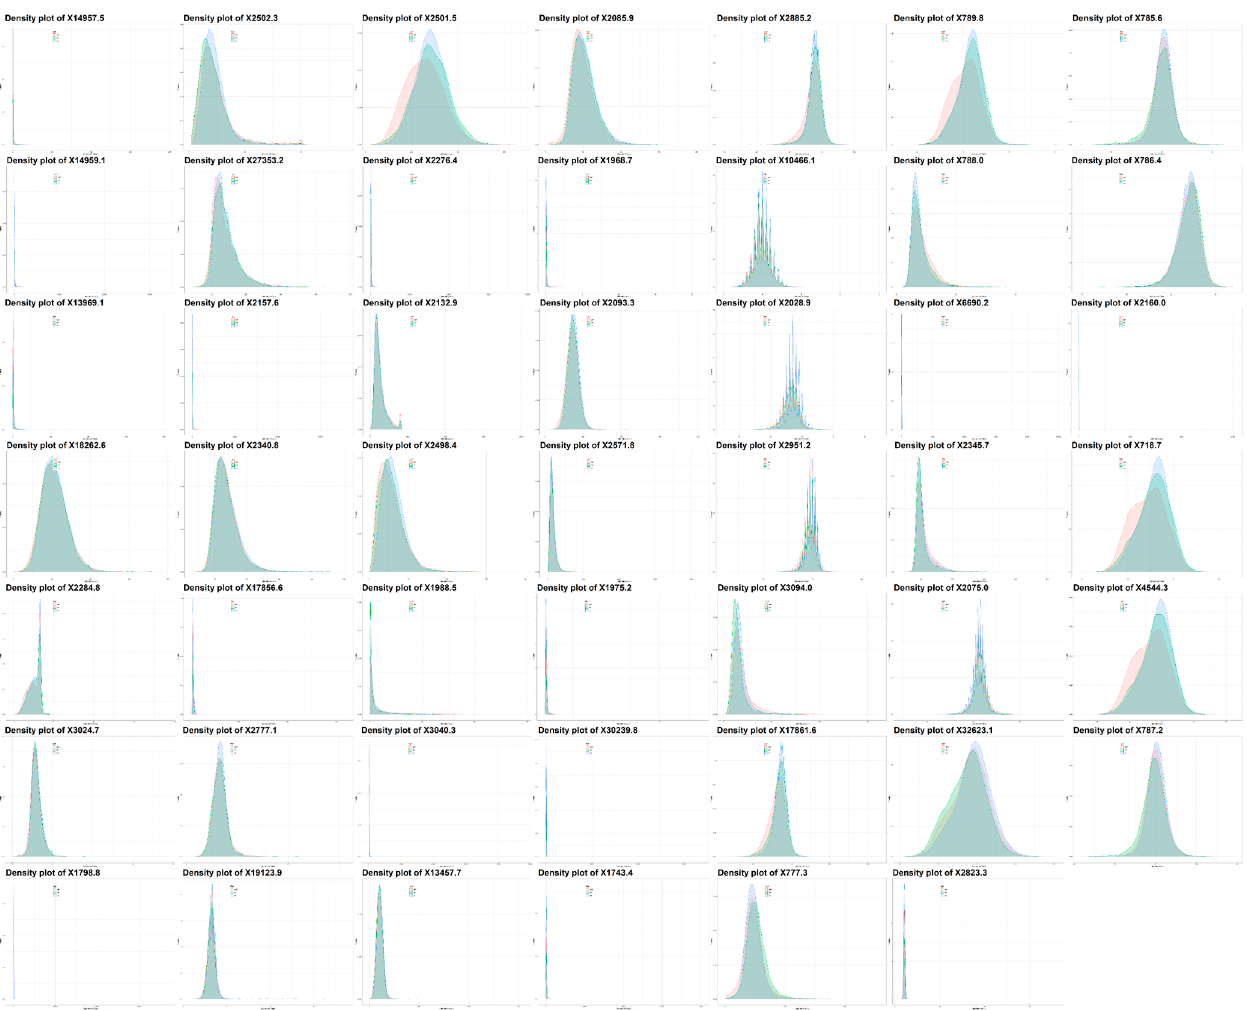
Figure A1. Distribution of the laboratory values normalized for all the LOINC included in this study. Table A1. Diagnosis codes used for inflammatory bowel disease and osteoarthritis.